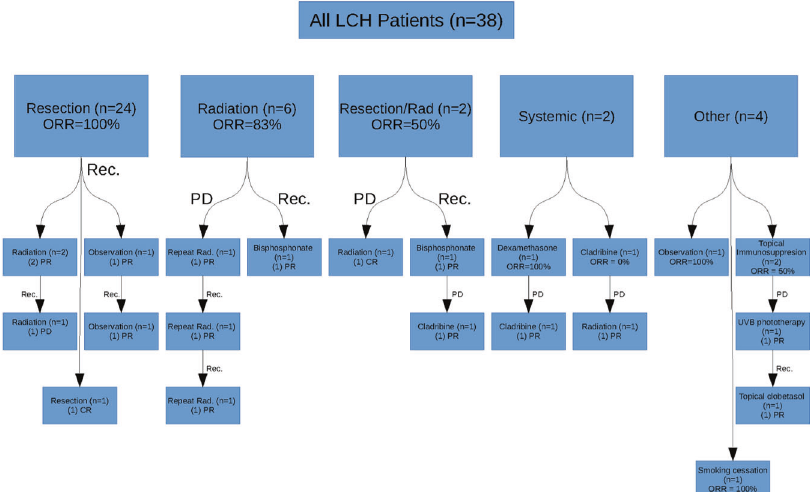
Fig. 1 Flowchart of treatment and outcomes of unifocal adult Langerhans cell histiocytosis. ORR overall response rate, PD progressive disease, rec recurrence, PR partial remission, CR complete remission, rad radiation, UVB ultraviolet